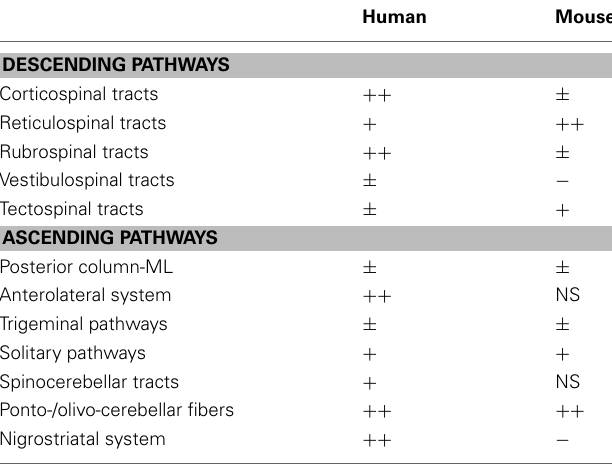
Table 1 | DAO activity in major neural